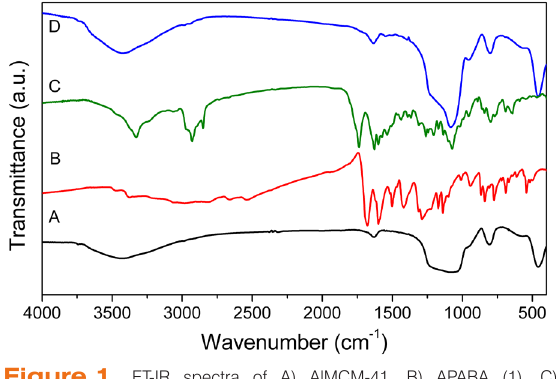
Figure 1. FT-IR spectra of A) AlMCM-41, B) APABA (1), C) triethoxysilane azobenzene derivative (4) and D)